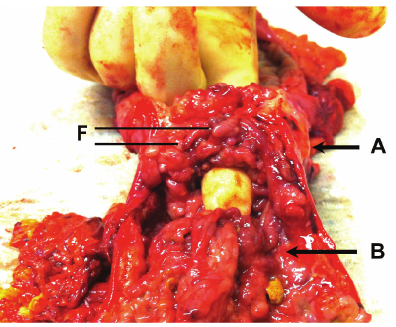
Figure 4: Section from left hemicolectomy showing a constricting mass in the distal transverse colon (Label A) and an adjacent synchronous mass in the proximal descending colon (Label B). Filiform polyps (F) are seen within both